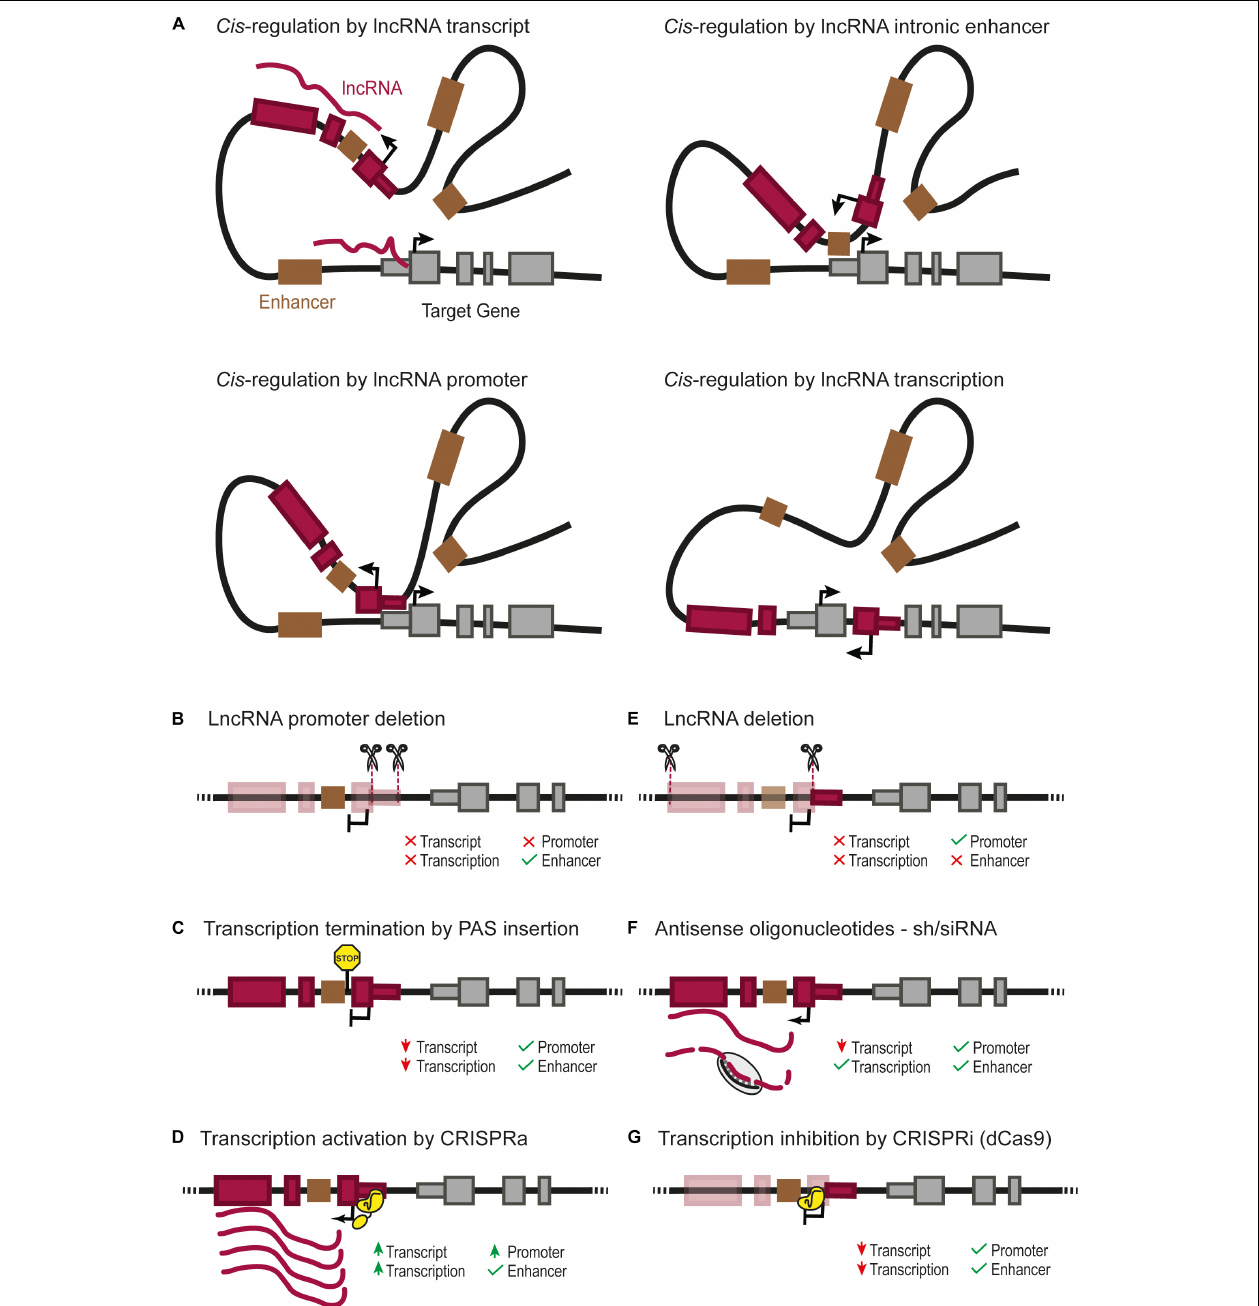
FIGURE 1 | (A) Four possible cis -regulatory mechanisms mediated by lncRNA genes. Cis -regulation of nearby genes can be achieved directly by the lncRNA transcript, by cis -regulatory elements overlapping with the lncRNA gene such as an enhancer (Groff et al., 2016), or the lncRNA promoter itself (Engreitz et al., 2016; Paralkar et al., 2016), or by the transcription of the lncRNA (Latos et al., 2012). Different types of genetic perturbation can provide insights into the underlying mechanisms, such as: (B) deletion of the lncRNA promoter, which can affect the transcription of the regulated gene due to the lack of lncRNA transcript, transcription or absence of direct cis -regulation by the lncRNA promoter (Engreitz et al., 2016; Paralkar et al., 2016); (C) insertion of a poly-adenylation signal (PAS) downstream of the transcription start site, which prevents the transcription of the lncRNA through downstream DNA sequences (Sleutels et al., 2002; Ohhata et al., 2007; Yin et al., 2015; Anderson et al., 2016; Engreitz et al., 2016; Paralkar et al., 2016); (D) over-expression of a lncRNA from its endogenous locus can be achieved by CRISPR-activation (CRISPRa) (Gilbert et al., 2014; Konermann et al., 2015; Joung et al., 2017); it should be noted that the CRISPR-activation of the lncRNA promoter can also increase a direct cis -regulatory activity of the lncRNA promoter; (E) deletion of the full lncRNA transcript, which leaves the lncRNA promoter as a potential cis -regulatory element; note that deletion of several exons of the lncRNA will also remove any intronic enhancer (Groff et al., 2016); (F) lncRNA knock-down using short hairpin RNA (siRNA/shRNA) or antisense oligonucleotides, testing the functionality of the lncRNA transcript itself; (G) RNA Polymerase II “roadblock” by CRISPR-dCas9 downstream of the transcriptional start site of the lncRNA (Gilbert et al., 2013; Qi et al., 2013); this selectively blocks the transcription of the lncRNA, helping to discriminate a cis -regulatory function from the transcription/transcript or from genomic cis -regulatory elements.